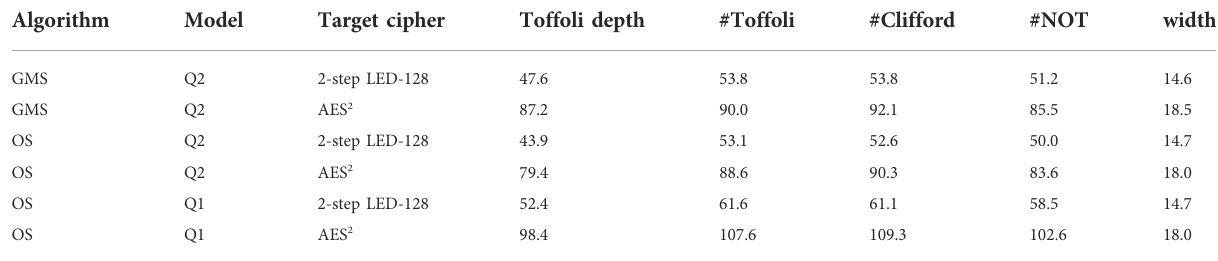
TABLE 7 Resource estimation for proposed quantum attacks on target ciphers, where all fi gures are in log base 2. The values of u of OS algorithm in Q1 model for 2-step LED-128 and AES 2 are 47 and 90, respectively. Algorithm